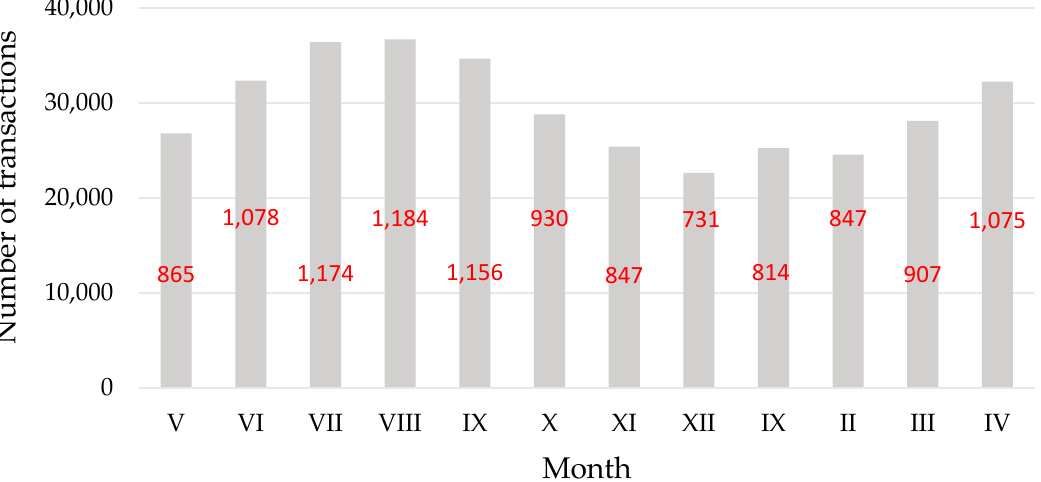
Figure 1. The sum of transactions in individual months. The red color marks the average number of transactions per day.